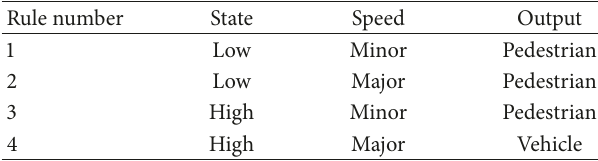
Table 5: Rule base for the RADAR fuzzy